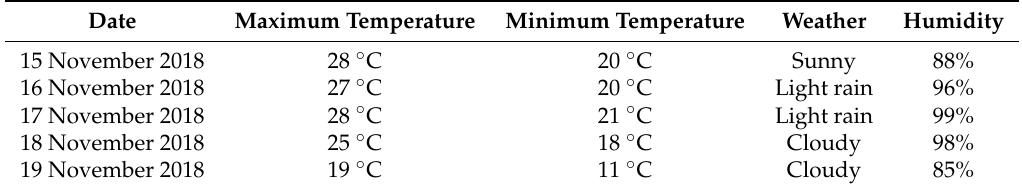
Table 1. Weather in experiment